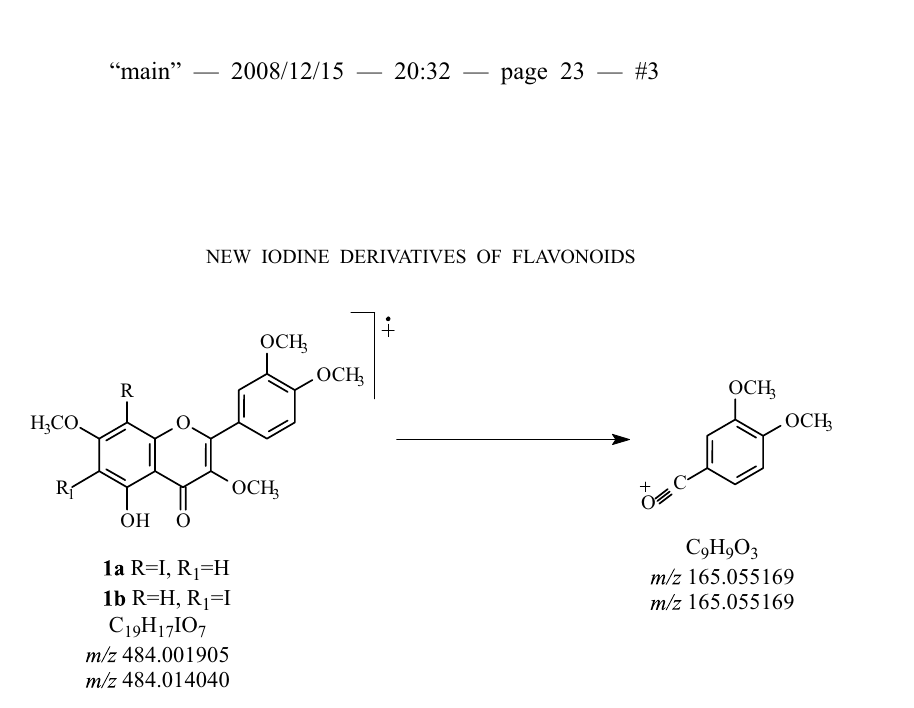
Fig. 2 – Proposed fragmentation patterns for 1a/1b derivatives based on the